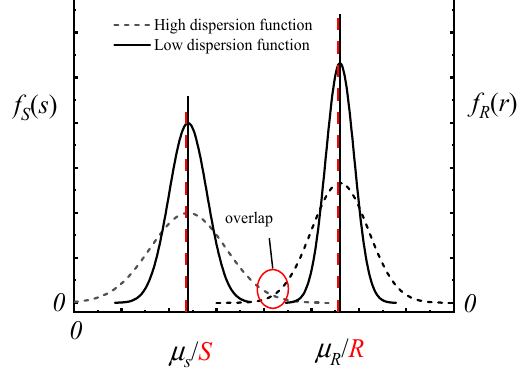
Figure 1. The probability density functions f R ( r ) and f S ( s ) of R and S